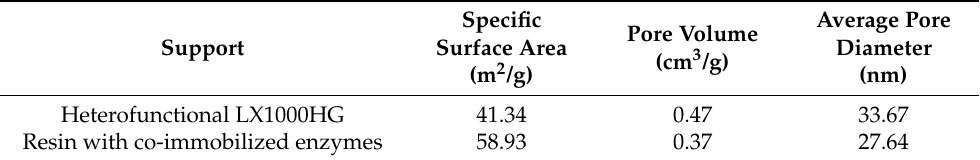
Table 2. Textural properties derived from N 2 adsorption of heterofunctional resin and support with derivatives.